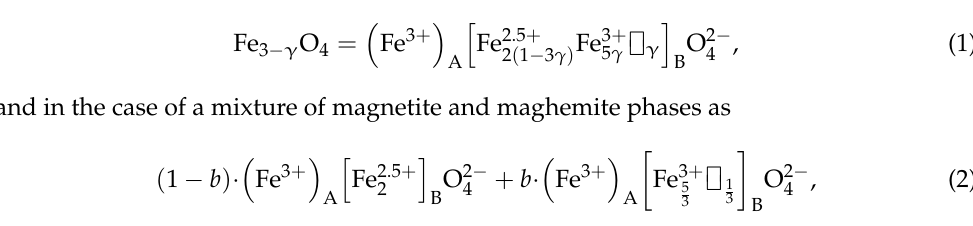
Figure 10. Diagram of limiting options for representing a magnetite nanoparticle with a spatially heterogeneous nonstoichiometry degree.